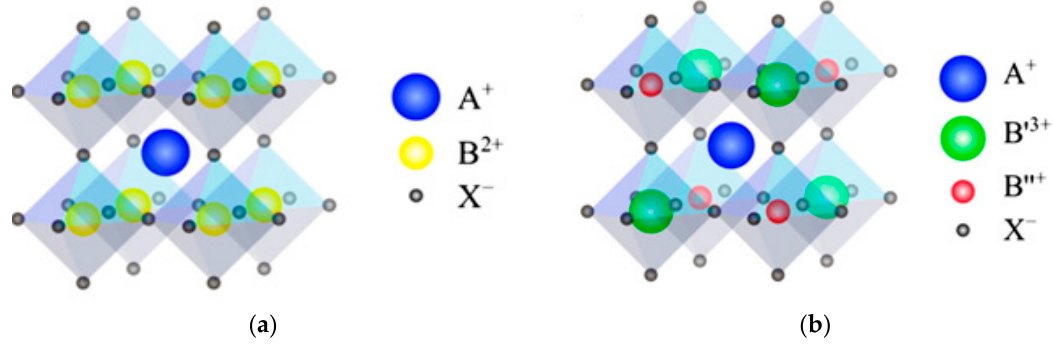
Figure 2. ( a ) Structure of ideal ABX 3 halide perovskites. ( b ) Structure of ideal A 2 B ′ B ″ X 6 halide double perovskites. Reproduced with permission from Reference [21]. Elsevier, 2018.